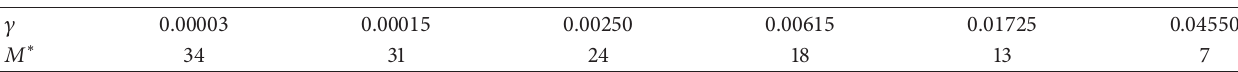
Table 2: The optimal system capacity of a network access proxy system for different values of controllable parameter 𝛾 ( 𝑝 = 0.15 , 𝜇 = 2 , 𝜃 = 0.9 , 𝛼 = 0.01 , 𝛽 = 5 , and 𝑁 = 5